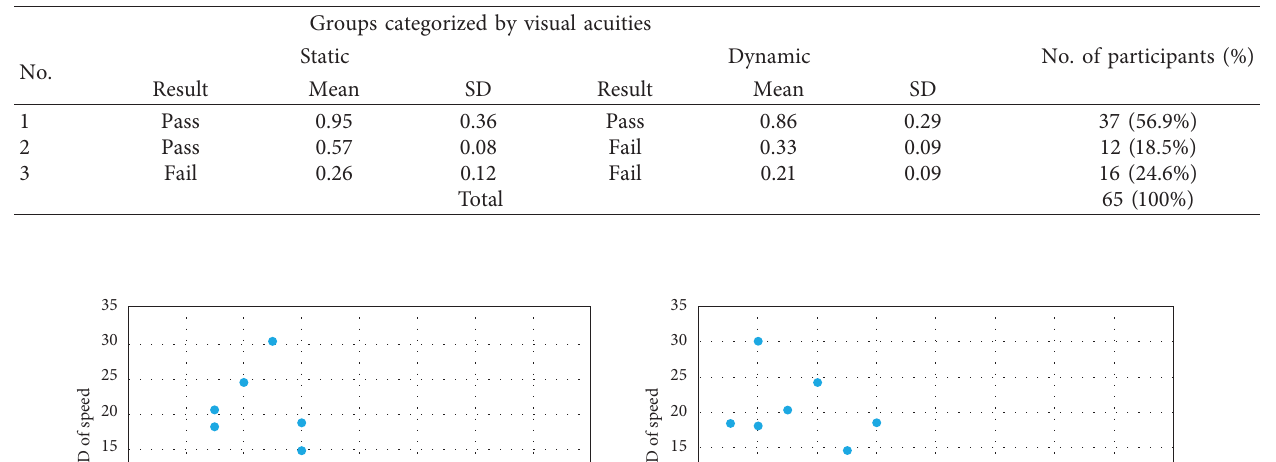
Table 2: Visual acuity evaluation